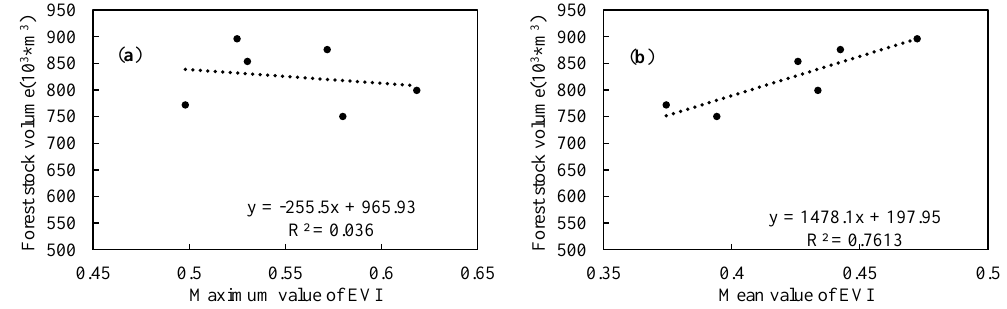
Figure 4. Temporal correlation analysis (2009–2015, excluding 2012). ( a ) Temporal correlation between maximum value of EVI and forest stock volume; ( b ) temporal correlation between mean value of EVI and forest stock volume.